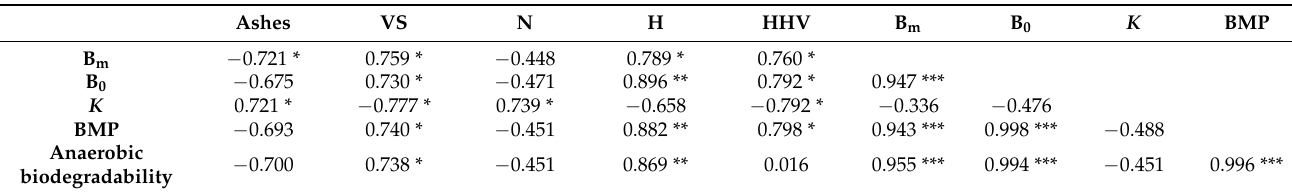
Table 5. Pearson’s coefficients for the correlations between plant composition, HHV and parameters related to the anaerobic digestion (n =